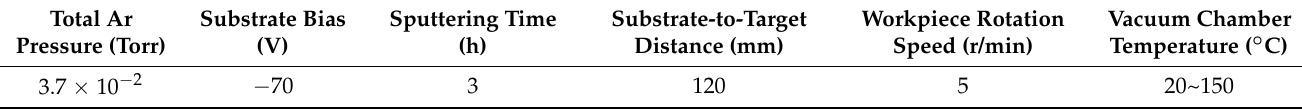
Table 2. The fixed parameters for the magnetron sputtering